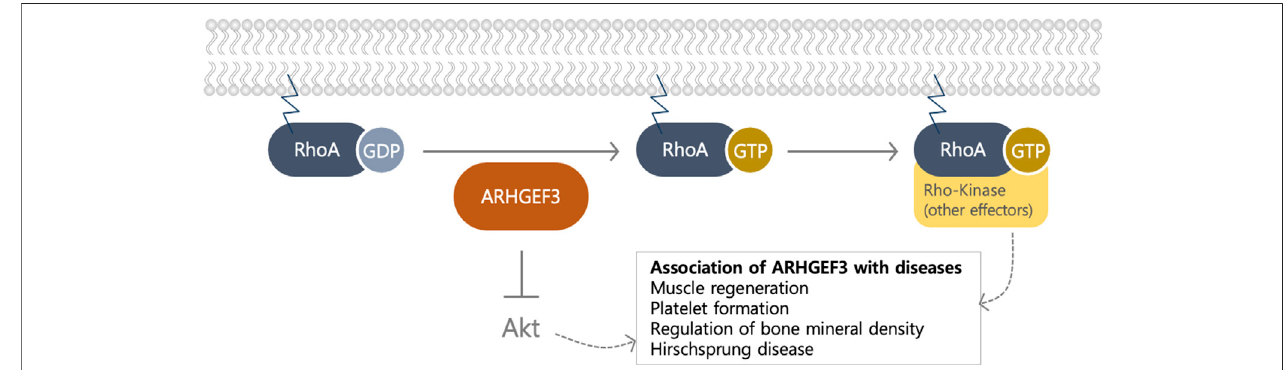
FIGURE 2 | The biological function of ARHGEF3 as a GEF and an Akt inhibitor. ARHGEF3 functions as a GEF to exchange GDP to GTP for RhoA/B and as an Akt inhibitor by binding to mTORC2. The association of ARHGEF3 was revealed via GWAS and knockout organism studies.